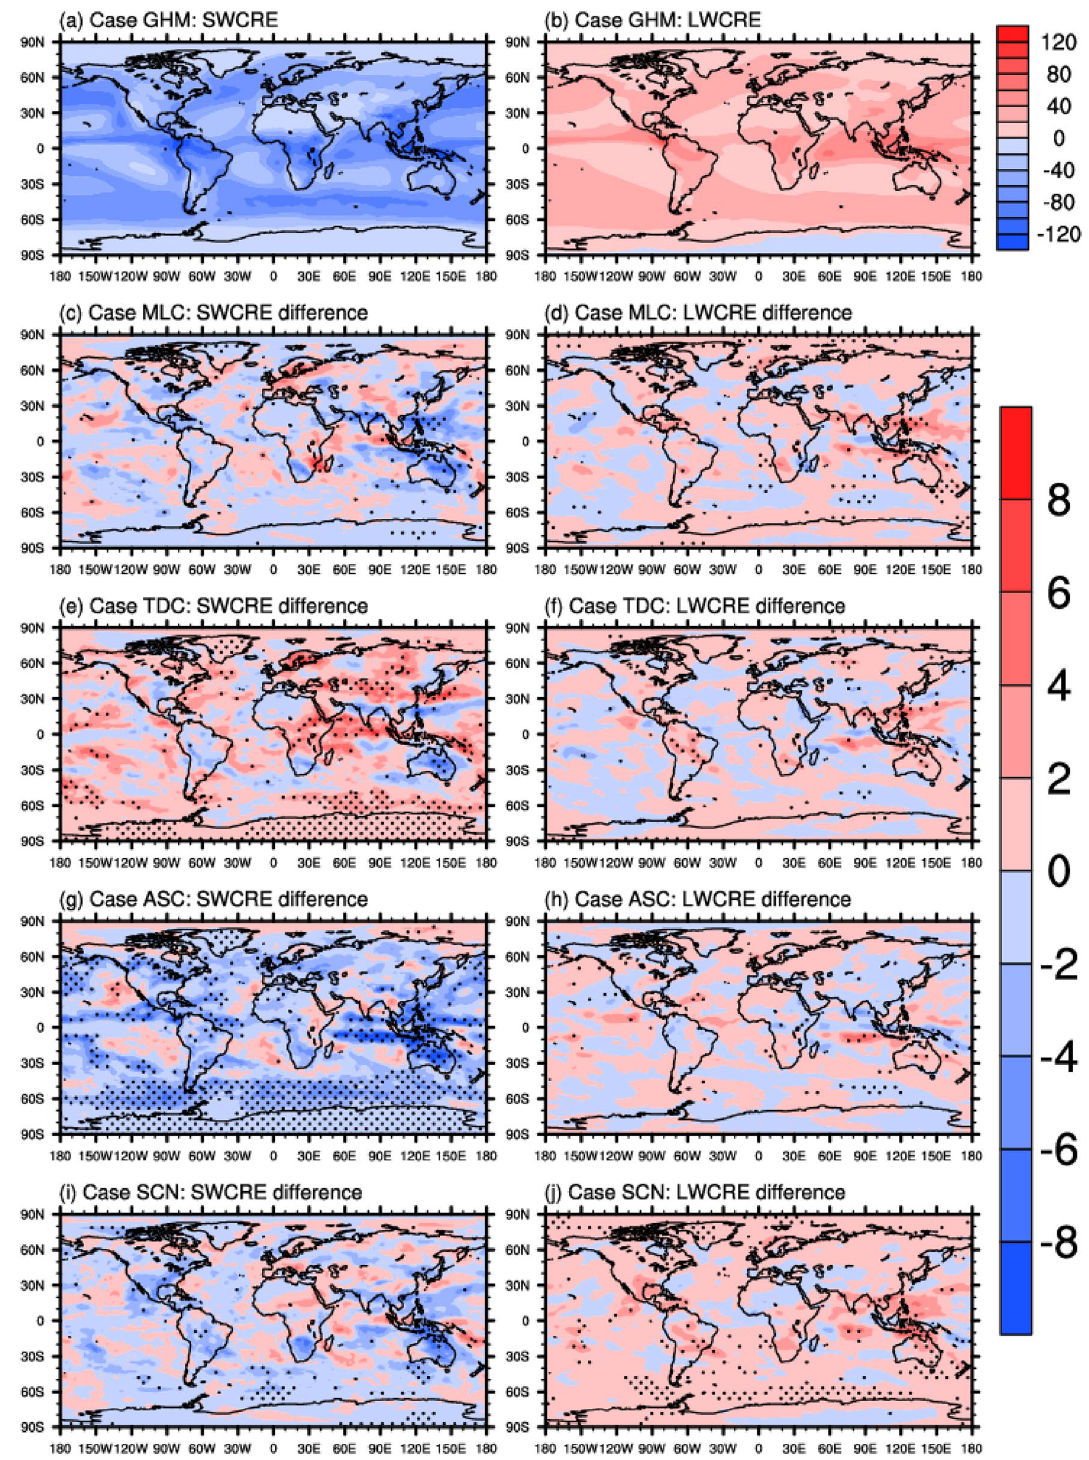
Figure 2. Simulated annual averaged SW and LW cloud radiative effects for the GHM case ( a , b ) and the corresponding differences between the MLC, TDC, ASC, SCN and the GHM cases ( c – j ). The left column panels are the shortwave CREs and the right column panels are the longwave CREs. Unit: W m −2 . Stippled areas indicate significant differences at the 95% confidence